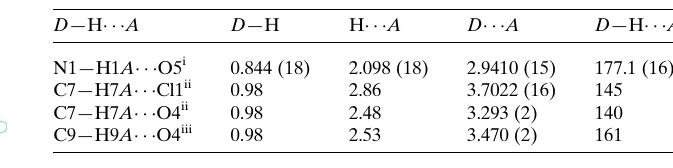
Table 1 Hydrogen-bond geometry (A˚ , (cid:2) ) for 3a